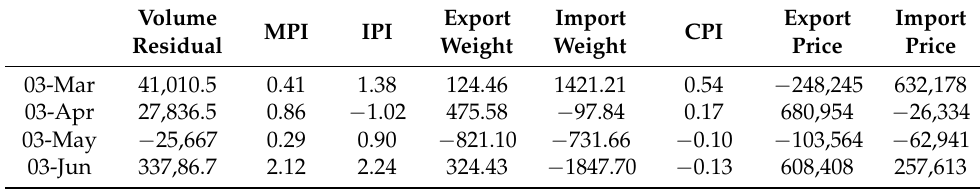
Table 5. Residuals combination of container volume with external indicators.